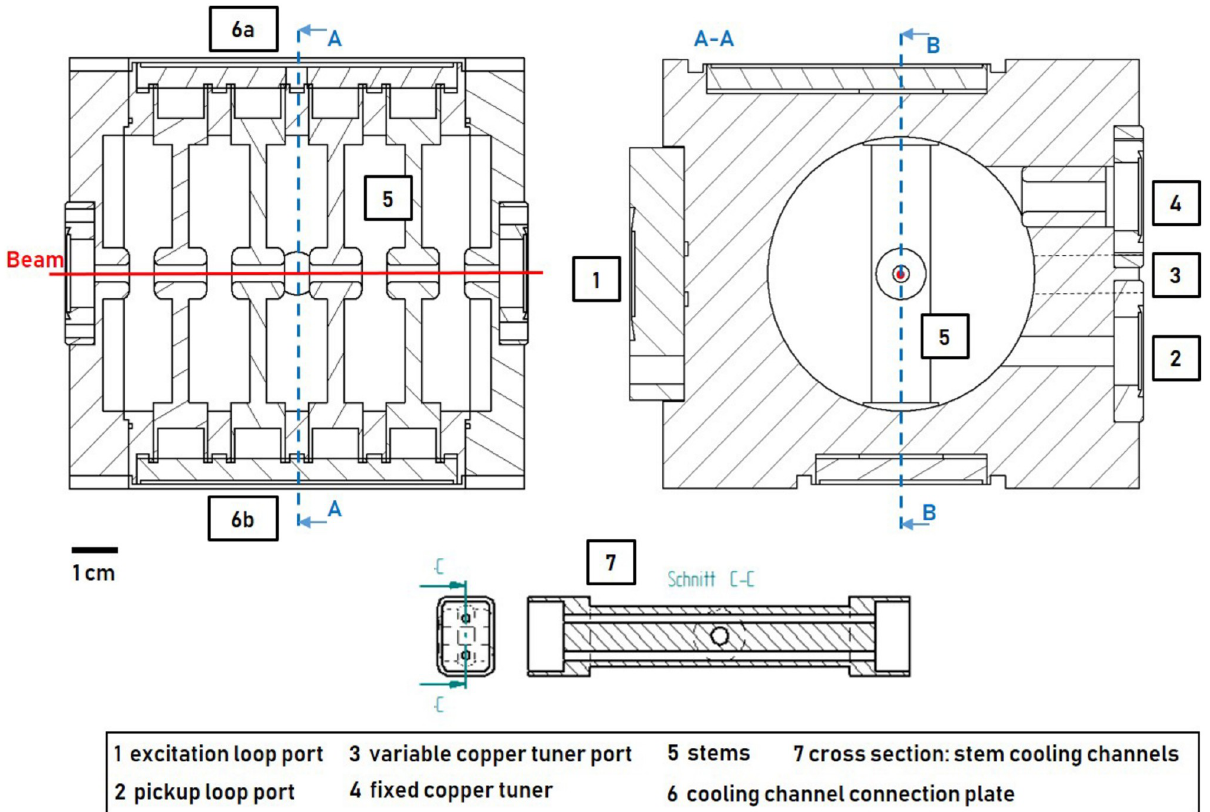
Fig 5. Cavity concept 2 (5-gap): Four drift tubes are attached by stems with implemented cooling channels. Pickup loop, excitation loop, fixed copper tuner and variabe tuner are depicted. Red line: proton beam.